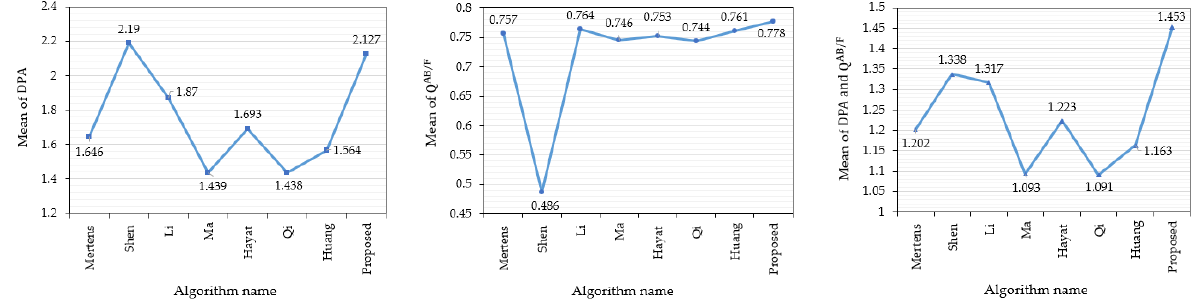
Figure 9. Use different methods to analyze the mean values of 𝐷𝑃𝐴 , Q 𝐴𝐵/𝐹 , and both of them.